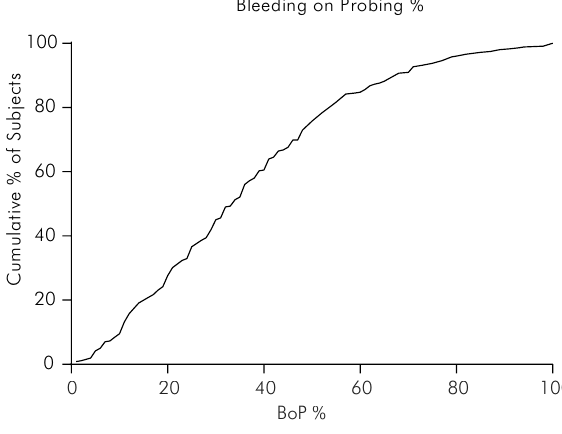
Figure 3. Cumulative percent of individuals according to bleeding on probing